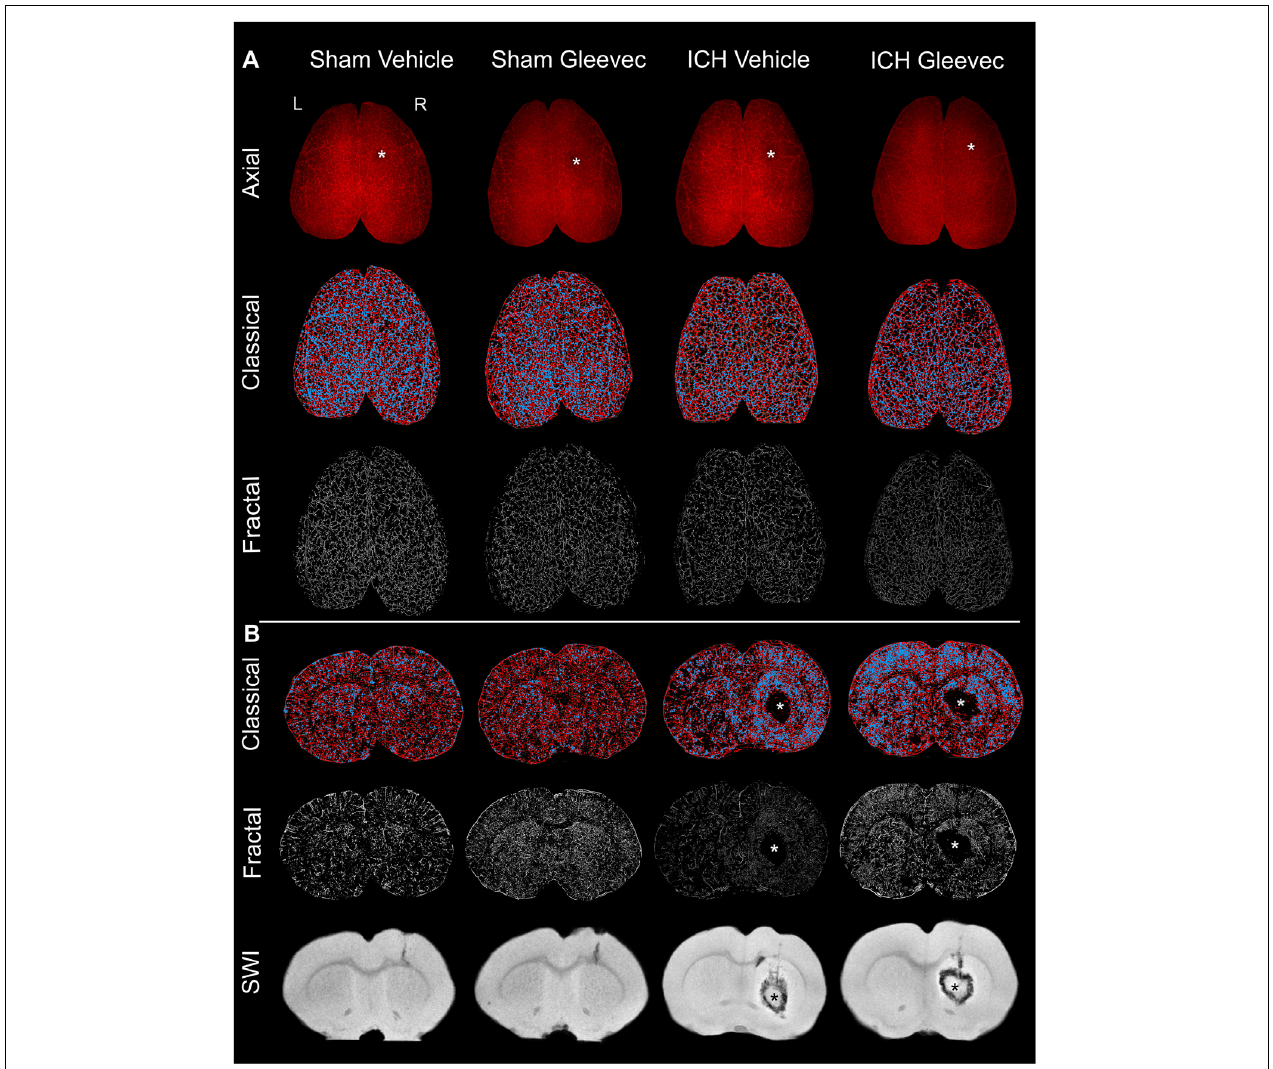
FIGURE 1 | Intracerebral hemorrhage (ICH) results in cerebral vascular decrements at 24 h after injury or treatment. (A) Axial: The top row illustrates representative axial vessel painted whole brains in ICH animals with and without Gleevec treatment (* = injection site). The middle row are sample classical vascular analysis maps where red denotes vessels and blue demarcates vessel junctions. The third row displays fractal maps utilized for analysis of vascular complexity. (B) Coronal: Classical vascular analysis of coronal sections from all experimental groups wherein the ICH lesion in the striatum can be visualized in the injured rats (*). Middle row are the corresponding fractal analysis maps. The last row of coronal images are from susceptibility weighted magnetic resonance imaging (SWI MRI) which was utilized to monitor the extent of the hematoma and edema after ICH induction. Sham animals exhibited minimal vascular alterations from needle insertion whereas ICH animals have prominent and extensive areas of vessel disruption at the site of the ICH. All images in each column are from the same